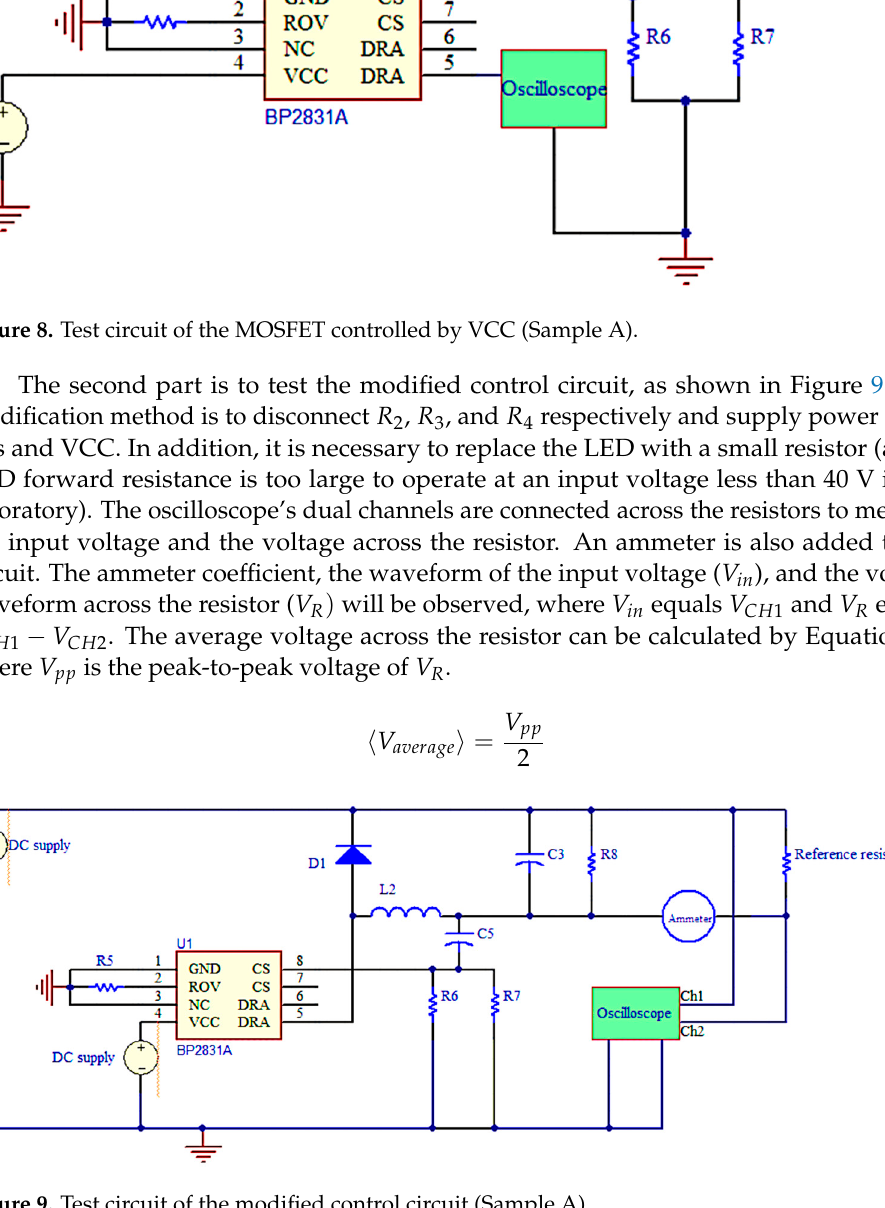
Figure 9. Test circuit of the modified control circuit (Sample A).